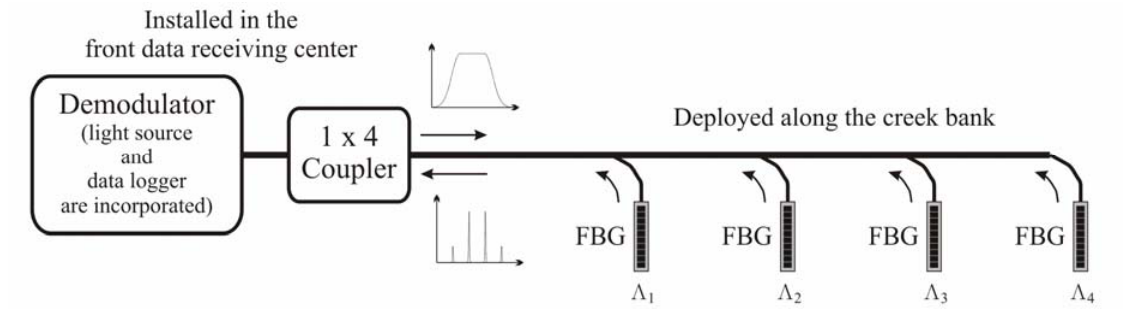
Figure 4. Proposed fiber-optic sensing system for monitoring debris flows. Four FBG accelerometers were installed in a line array along the bank of a creek. Four reflected signals were combined into one using a four-port (1 × 4) fiber coupler and were then sent to the